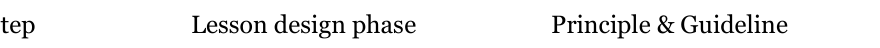
Principles and Guidelines for Implementation of OER-based Lesson Design